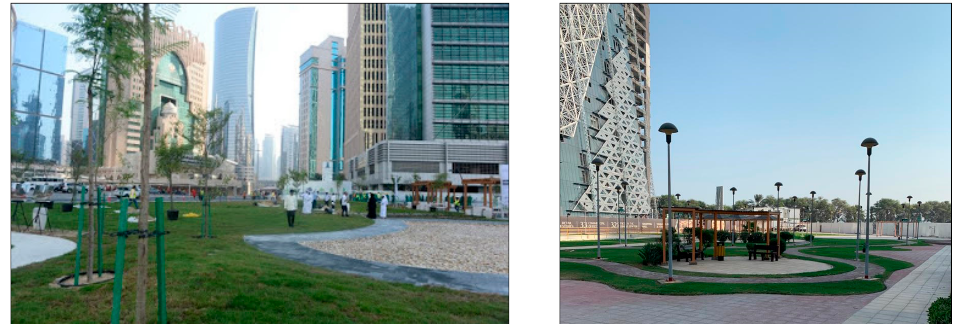
Figure 12. Graze Café and Monoprix hypermarket and café, on the ground floor of Palm Towers (Source: the Authors). Figure 13. ( left ) Al Abraj Park, next to the State Audit Bureau building; ( right ) the park next to Qatar Cool Tower (Source: the Authors).